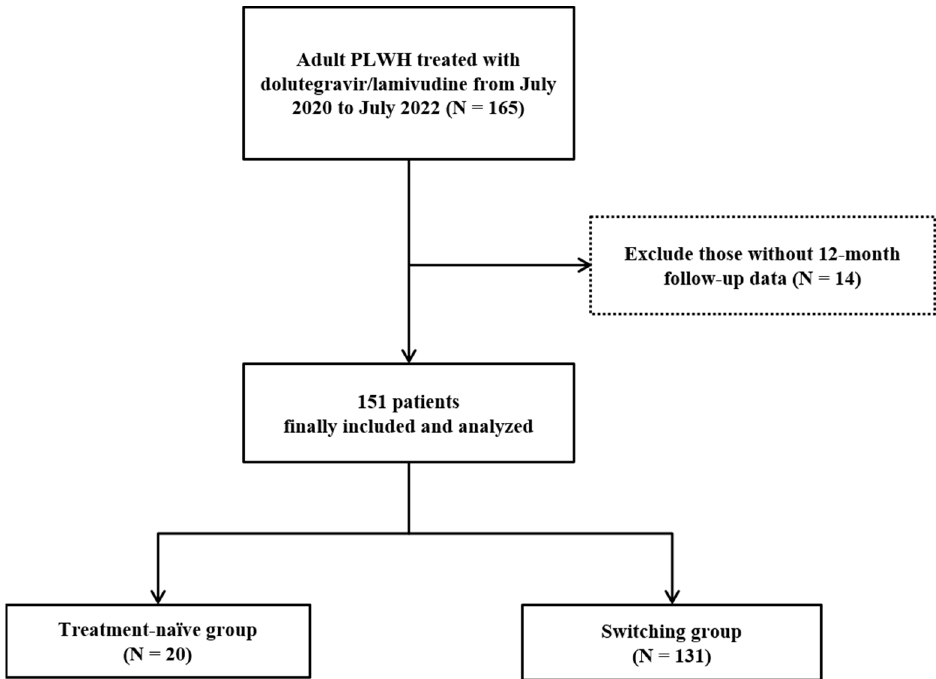
Figure 1. Flow chart for the participant selection method used in this study. Of the 131 people in the switching group, 110 (84.0%) were changed to DTG/3TC for drug simplification, and 3 (2.3%) people changed due to gastrointestinal problems, such as diarrhea or indigestion. The remaining 8 (6.1%) patients changed because of the side effects of the existing medicine, and 10 (7.6%) changed due to unknown reasons. The ART types previously used by those in the switching group are listed in Table